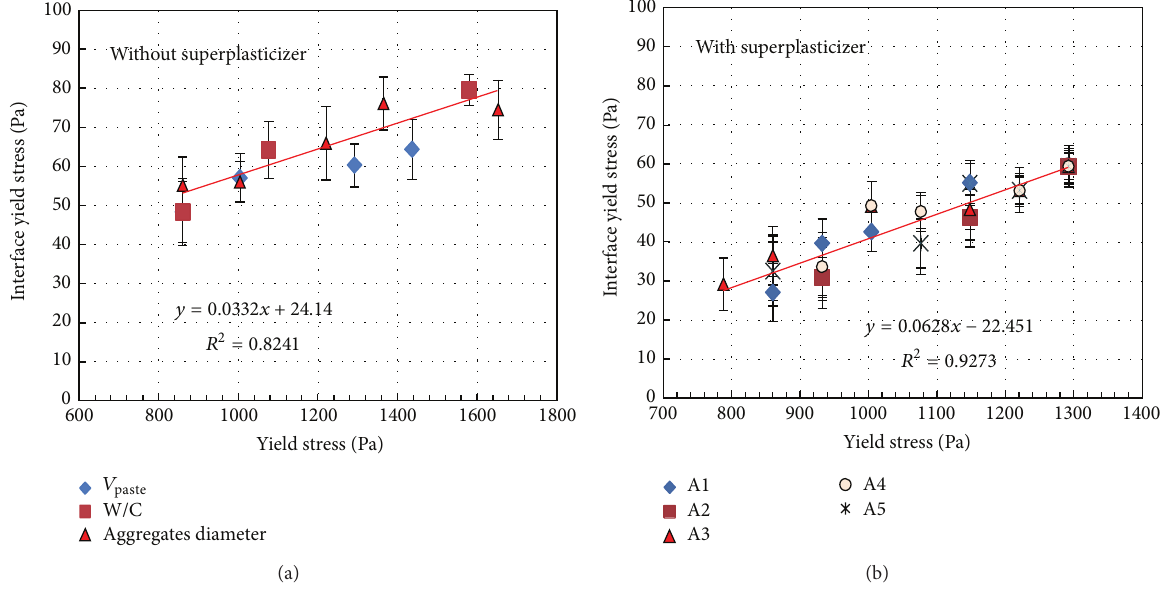
Figure 12: Evolution of the interface yield stress 𝜏 0𝑡 according to the concrete yield stress 𝜏 0 calculated by (13): (a) concretes series without superplasticizer and (b) concretes series with superplasticizer.